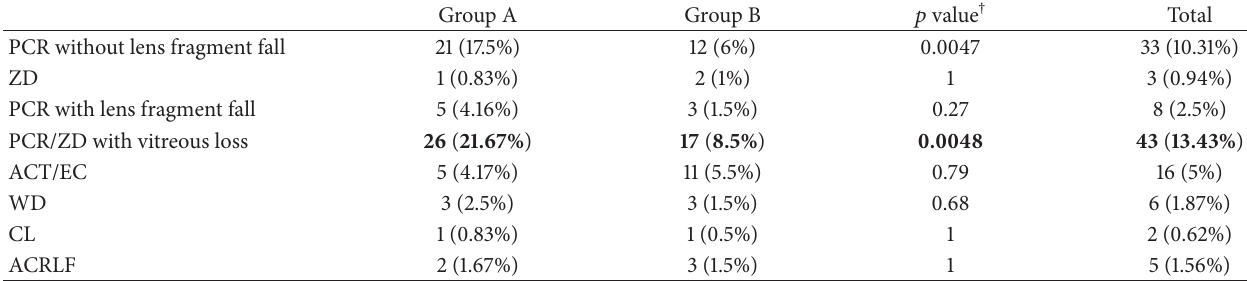
Table 3: Intraoperative complications rates of the first 40 phacoemulsification cases per resident for each study group and respective 𝑝 values. Percentages are given in parentheses.